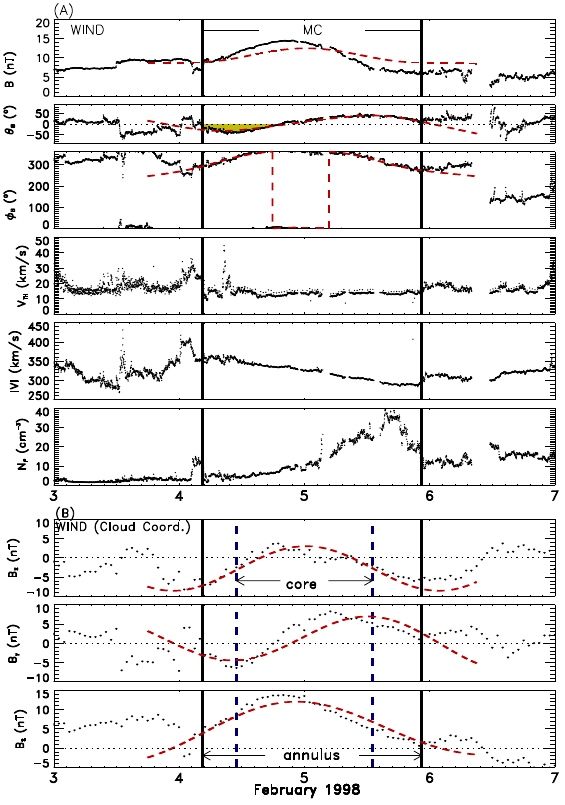
Fig. 8. (A) The magnetic field profile (in GSE coordinates) of a so- called core-annulus MC, in this case occurring on 4 and 5 February Days 35 and 36, 1998, where the (outer) annulus fitting interval is shown by two vertical solid lines, in the same format as Fig. 4 where the red dashed curves are model-fits. The region shaded in yellow is where the observed B z component is southward. (B) The same MC shown for the magnetic field only and in Cloud coordinates in a Cartesian (B X , Y , Z , CL ) format; again, the model field is shown as smooth red dashed curves. Now we show two sets of boundaries, the inner (core) boundary and again the outer (annulus) boundary. The max and min in B Y , CL (at the dashed vertical lines, which de- termine the boundaries of the core) should be in phase with that B X , CL -polarity change – as we see they approximately are. There were four examples of this type of MC among the 82MCs; see the asterisks (*) on check (ck%) in Table